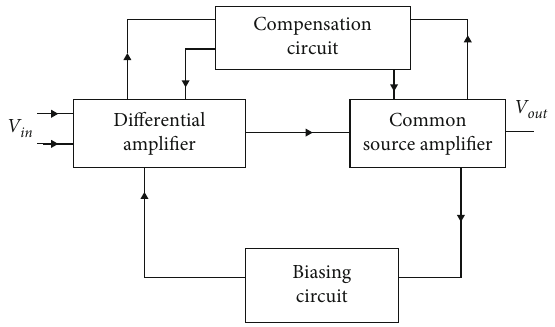
Figure 7: Two-stage di ff erential ampli fi er design using FinFET.